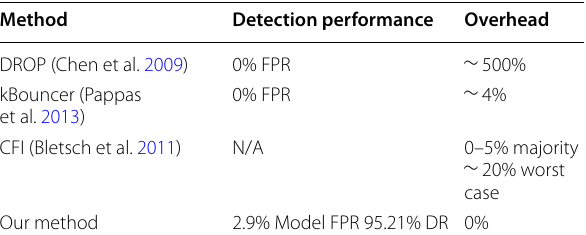
Table 7 Illustration of trade-offs between different ROP detection methods